Question: What form of chart is displayed?
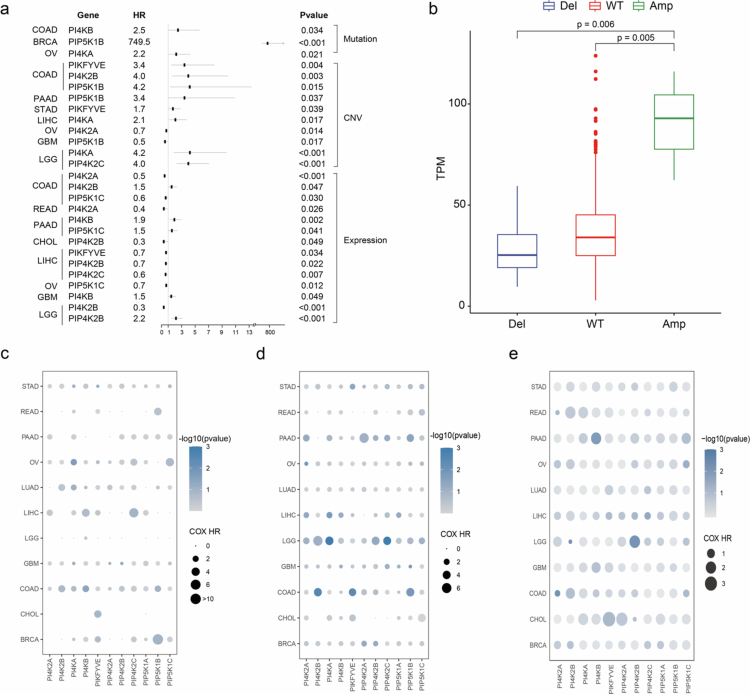
Answer: forest